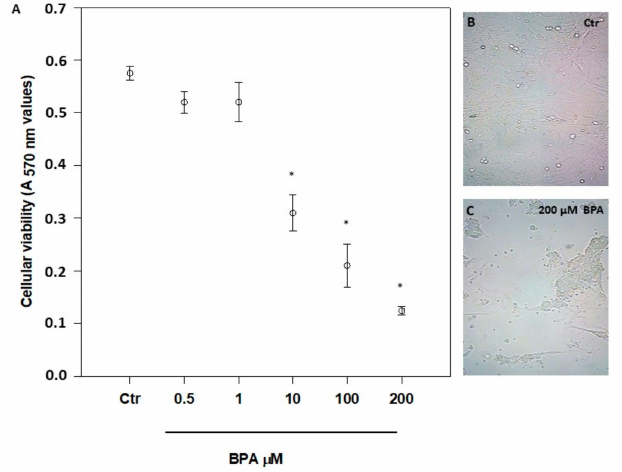
Figure 1. E ff ect of increasing concentrations of BPA on mouse Sertoli cell viability ( A ), and morphology ( B , C ), after 48 h of treatment. Magnification, × 200. Data are expressed as means ± SEM of 5 independent experiments. * p < 0.01 vs. vehicle-treated controls